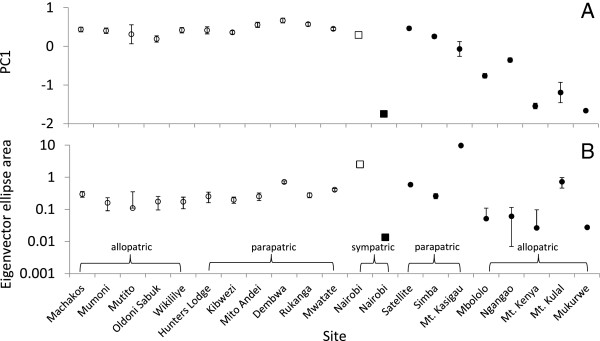
Comparison of acoustic space as measured by first (dominant) eigenvector A. (upper panel) and the ellipse area B. (lower panel) spanned by the first two eigenvectors of principal coordinates analysis occupied by sym-, para-, and allopatric populations of the lowland Zosterops abyssinicus (white) and the highland Z. poliogaster (black). The sympatric Nairobi populations are indicated by squares.